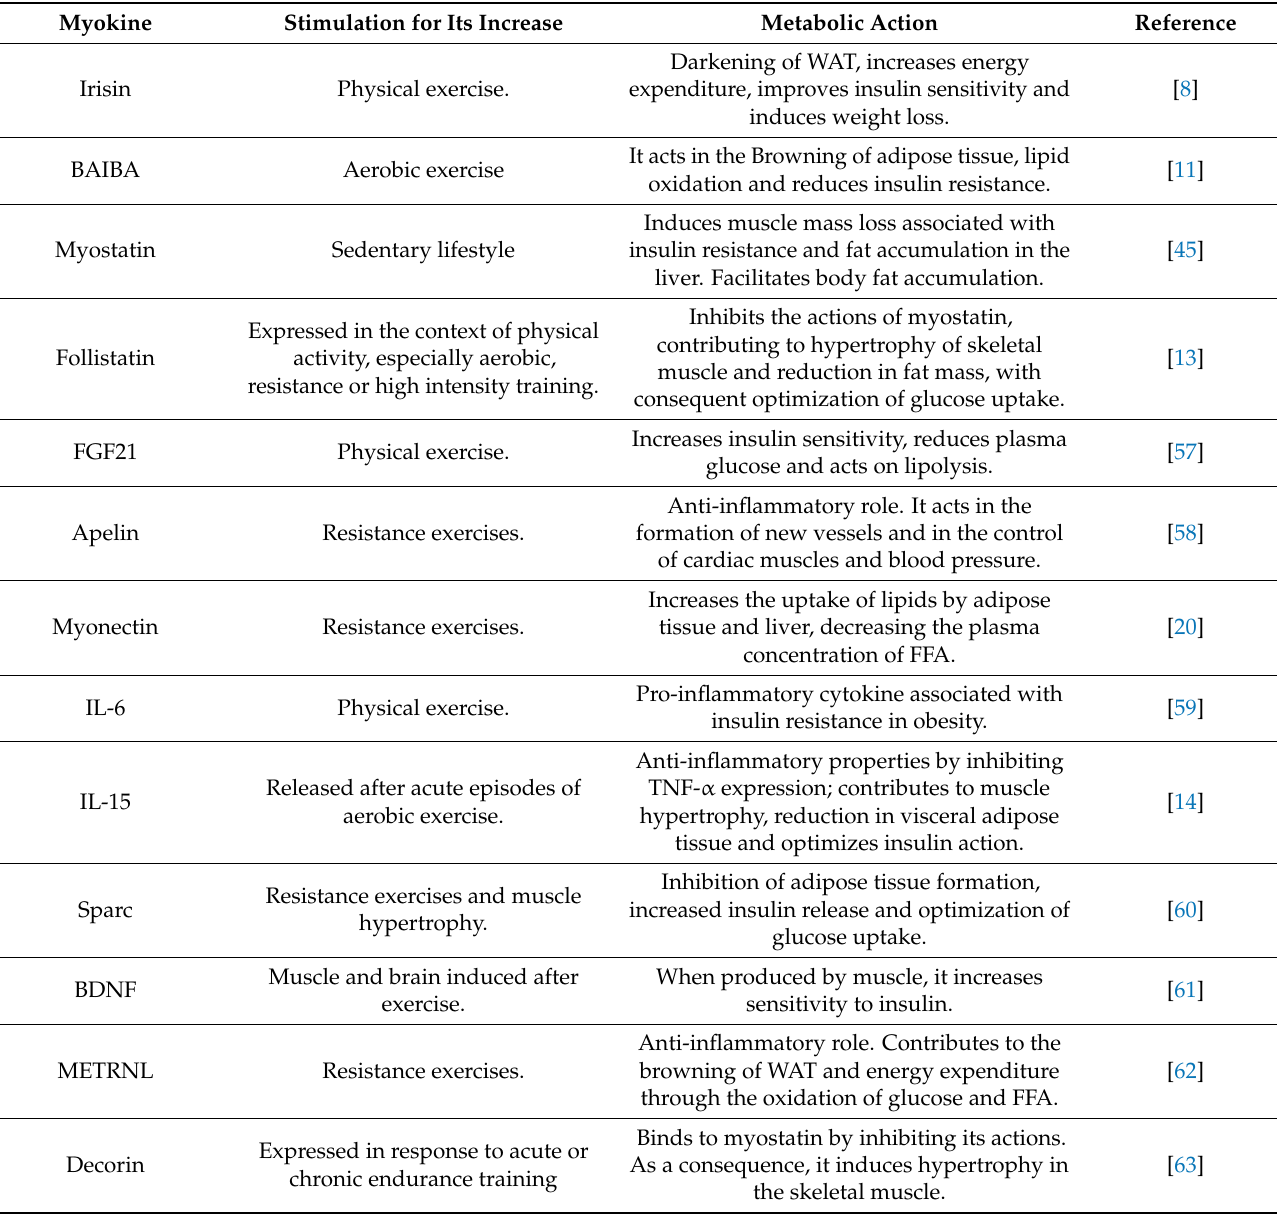
Table 2. Main characteristics of the